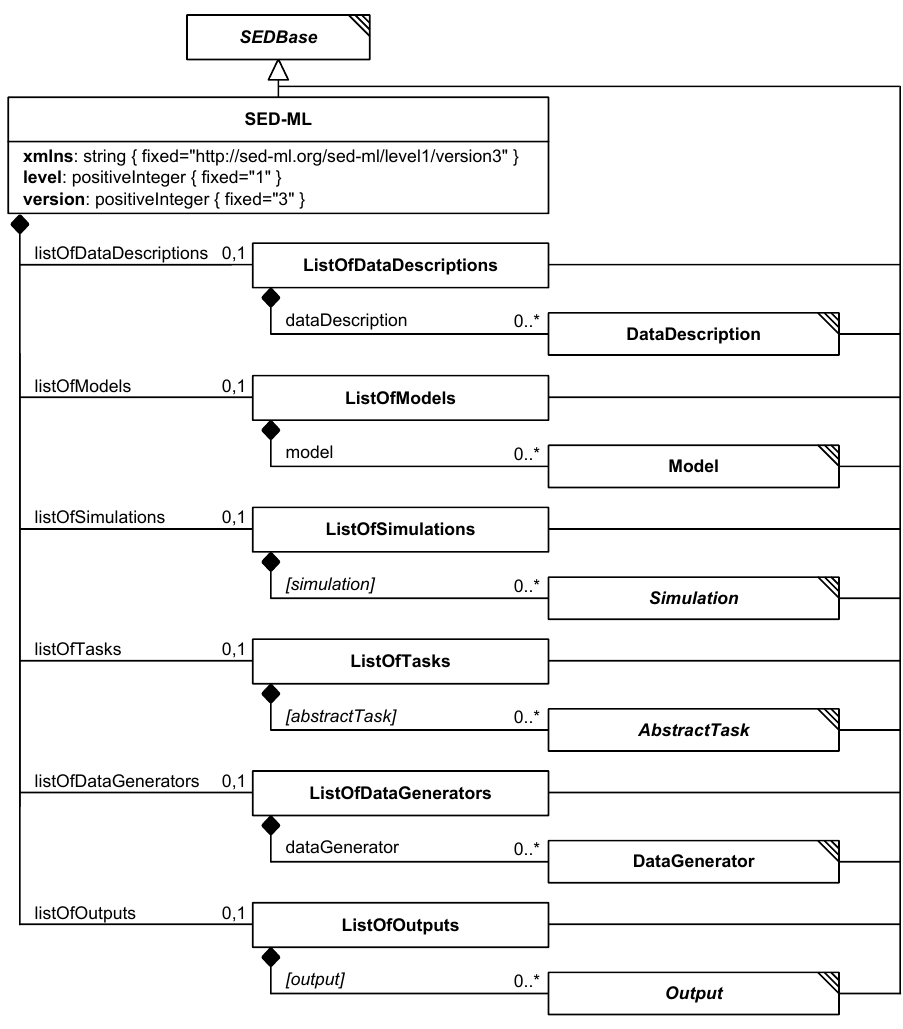
Figure 2.7: The SED-ML class